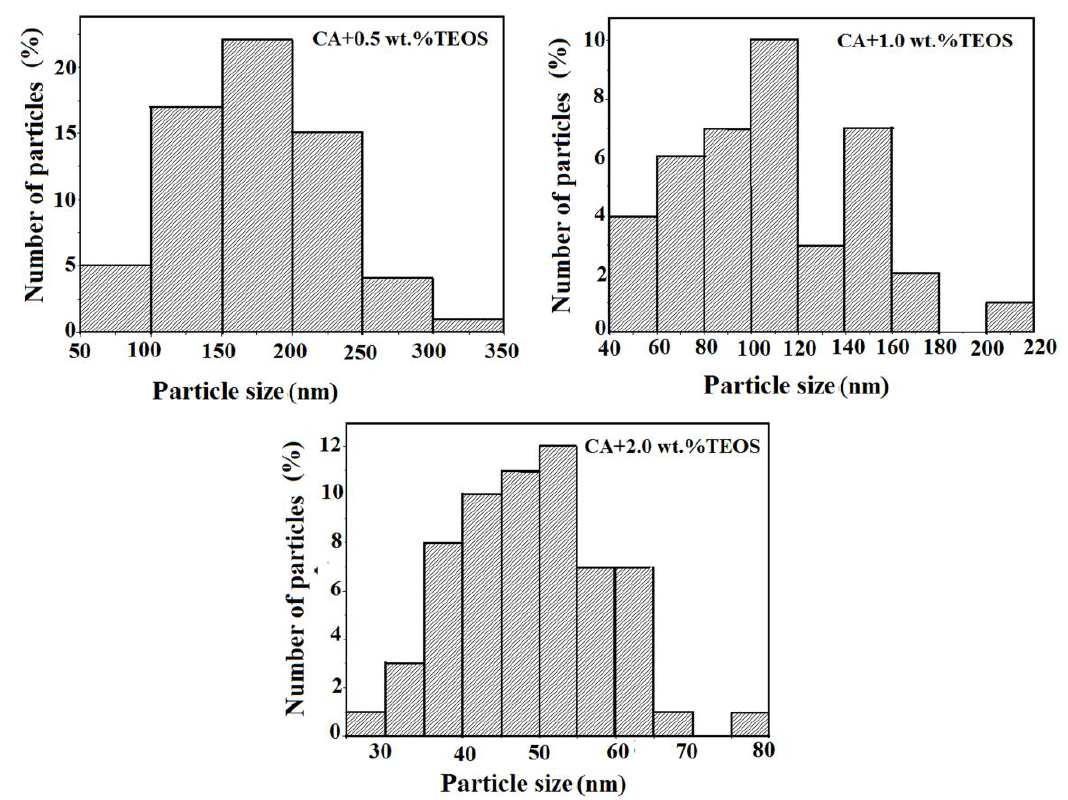
Figure 4. Particle size distributions obtained based on 2D AFM images for cellulose acetate/silica films.